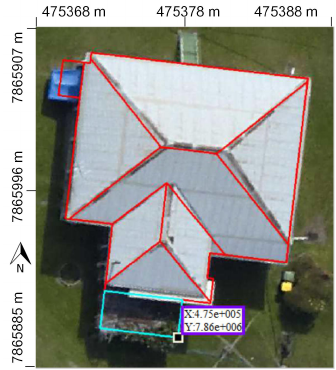
Figure 9. Extracting X and Y coordinates of a point of the cyan plane, where X and Y values are highlighted by a purple